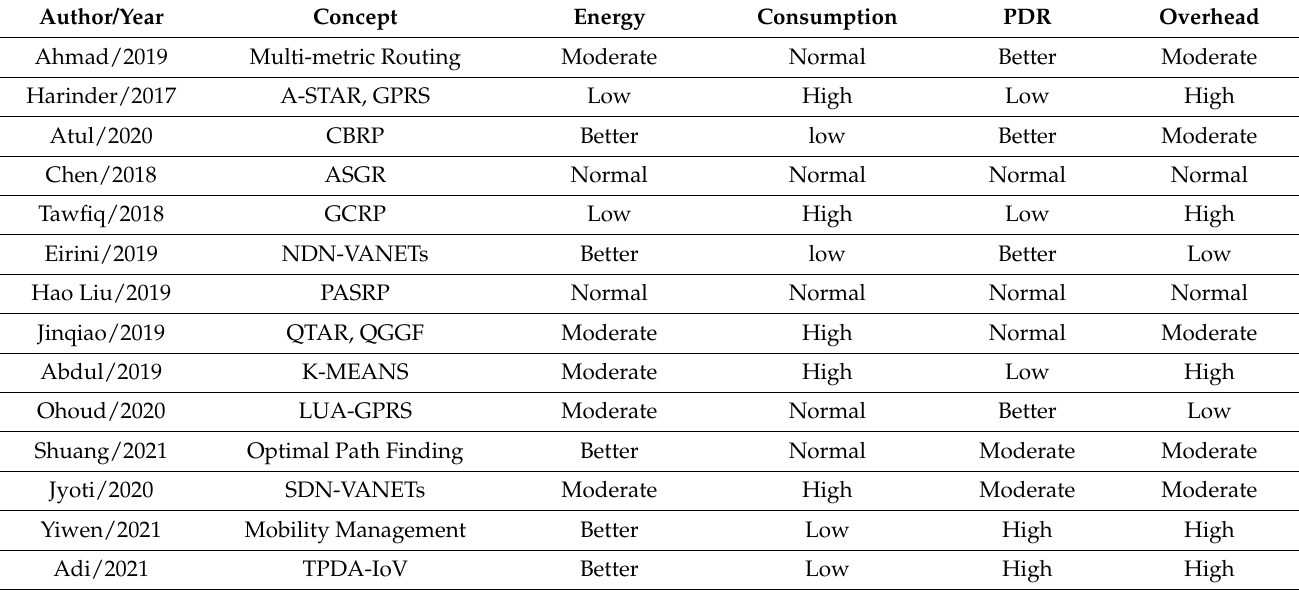
Table 1. Performance Analysis of Earlier Methods.